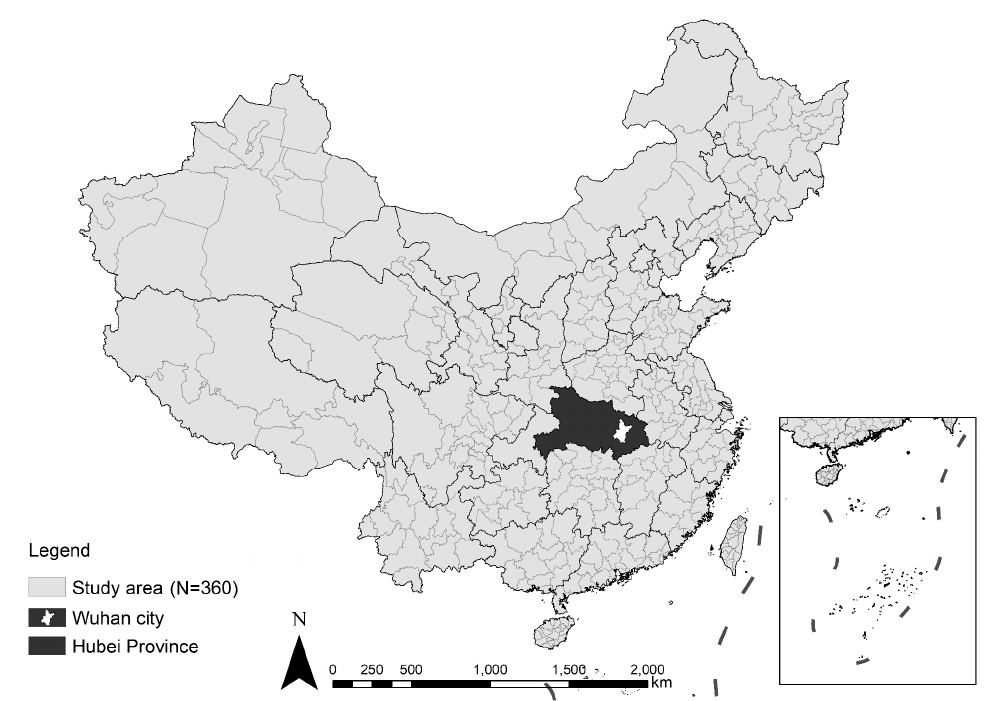
Figure 1. Study area.